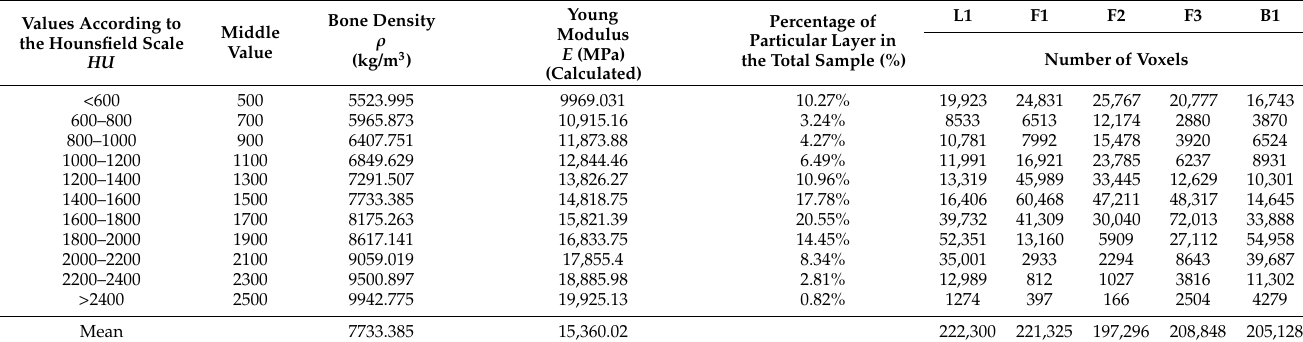
Table 9. Bone density with Young’s modulus for individual density